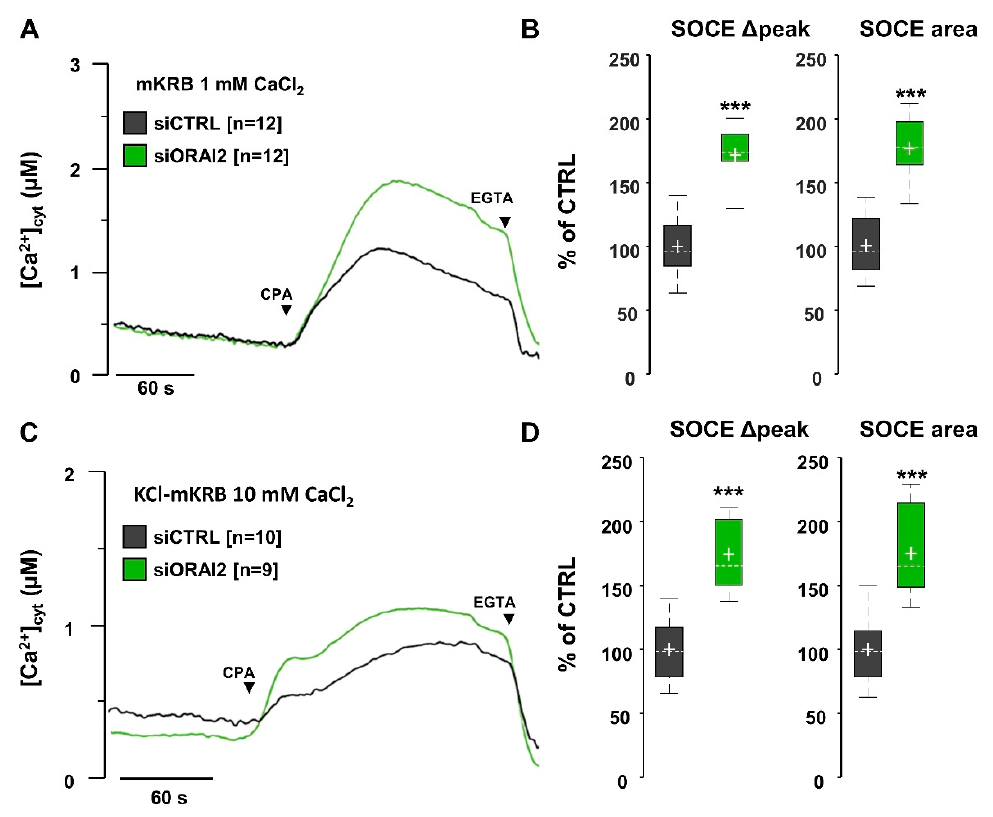
Figure 5. ORAI2 downregulation increases SOCE in H4-APPswe cells. Cells were co-transfected with siCTRL or siORAI2 (25 nM) plus the cDNA coding for cytAEQ. After 48 hours, cells were bathed at 37 °C in mKRB ( A,B ) or KCl-mKRB ( C,D ) containing 1 or 10 mM CaCl 2 , respectively. Cells were then treated with CPA (20 μ M) to activate SOCE. At the end of the experiment, cells were bathed in Ca 2+ -free, EGTA-containing medium to stop Ca 2+ entry. ( A,C ) Representative traces are shown for siCTRL (black) and siORAI2 (green) transfected cells, respectively. ( B,D ) Boxplots of SOCE Δ peak and AUC, measured within two minutes upon baseline subtraction. Data are expressed as percentage of CTRL, n = number of coverslips, Wilcoxon-Mann-Whitney test *** p < 0.001.